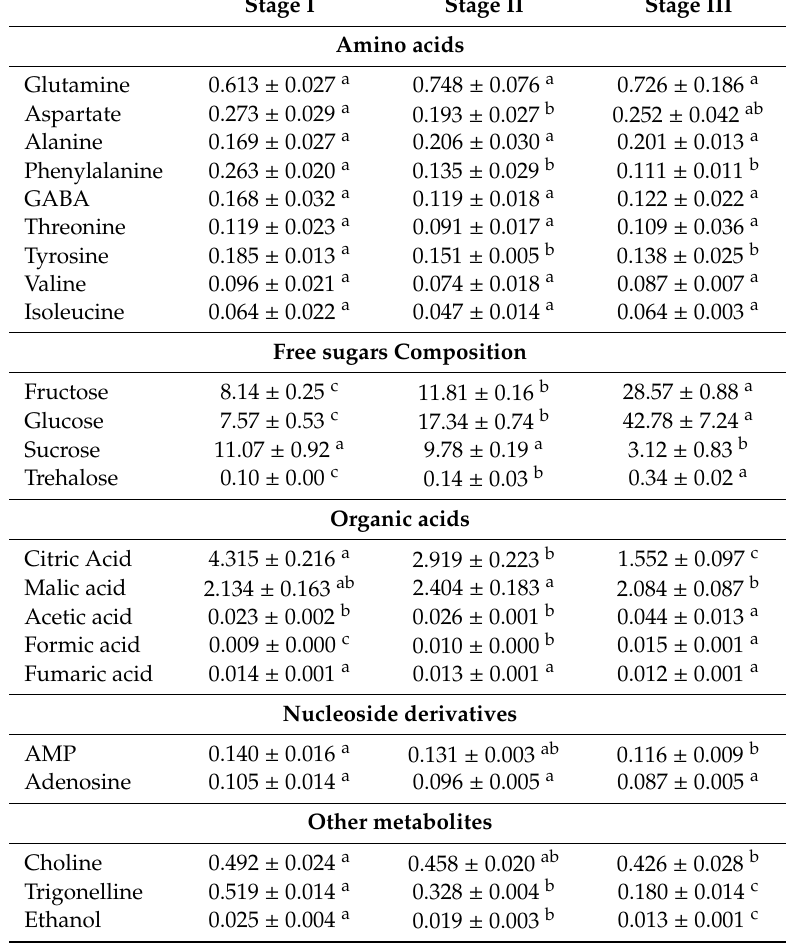
Table 1. Primary metabolites (mg / g d.w.) of the di ff erent maturity stages of Aloe vera flowers. Stage I: immature; stage II: mature; stage III: mature with stamens exposed to the